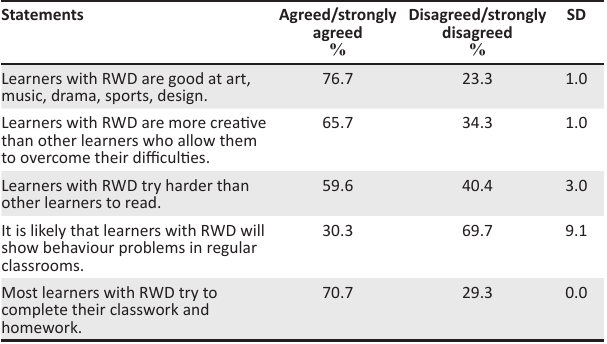
TABLE 3: Participants’ perspectives about characteristics of learners with reading and writing